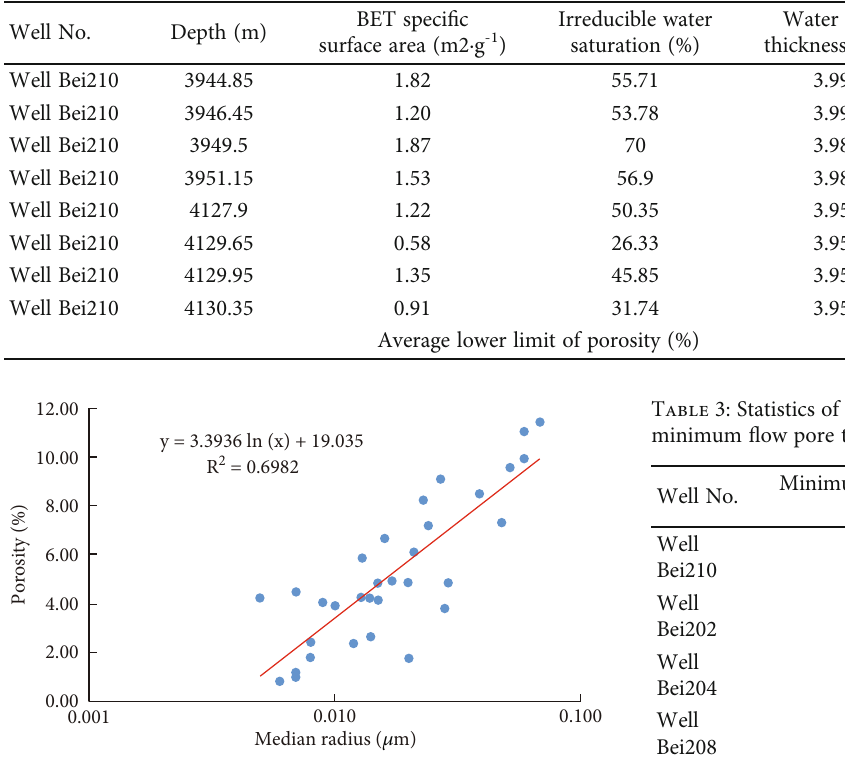
Figure 9: Cross-plot of the relationship between median radius and porosity.